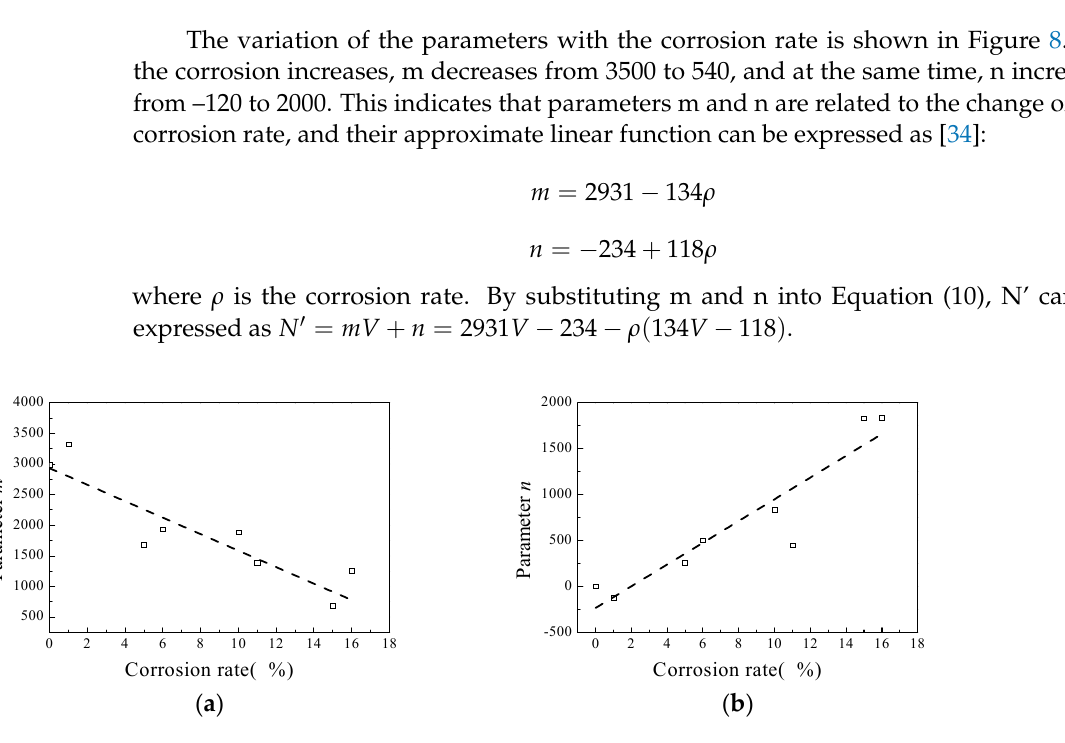
Figure 9. Correlation curve of the load and damage degree.